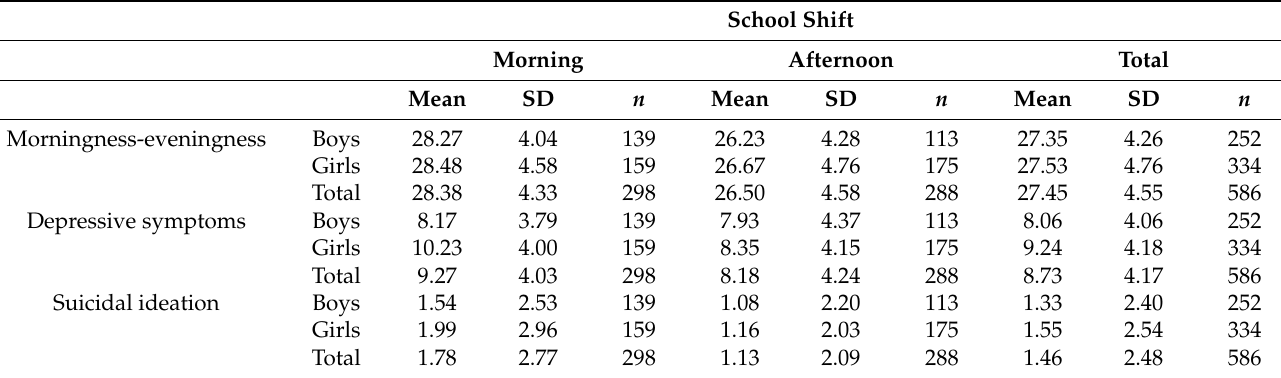
Table 3. Means, standard deviation (SD), and the number of participants according to school shift and sex for morning- ness/eveningness, symptoms of depression, and suicidal ideation.